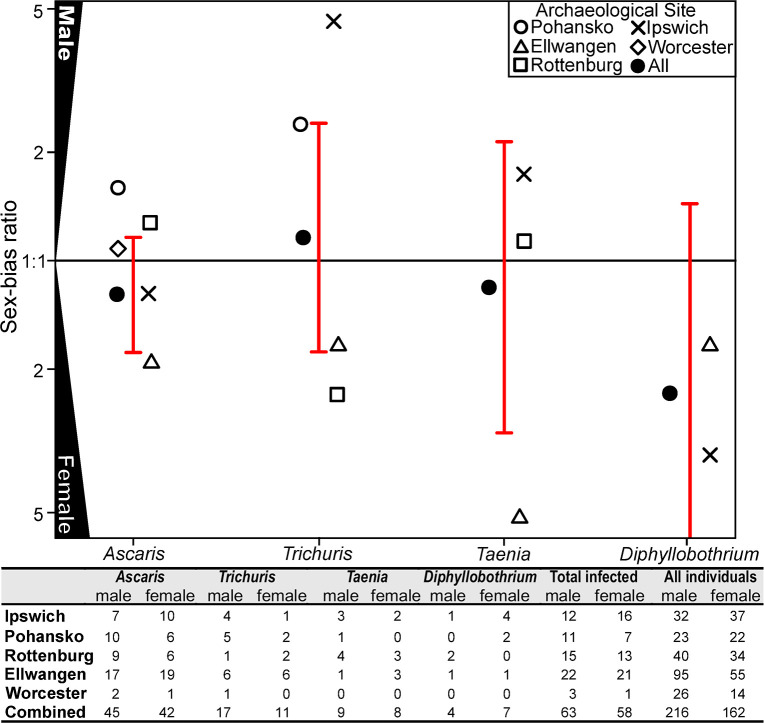
The prevalence of helminth infection in males and females.The ratio of infected male to female individuals for each of the four parasites, Ascaris, Trichuris, Taenia and Diphyllobothrium. Each of the sites indicated by a different symbol. The actual numbers of males and females infected with each parasite are given in the Table below the graph as is the cumulative total of all sites and the total numbers of males and females identified at each site. The bars represent the 95% confidence interval of all sites and no significant differences were identified according to sex.